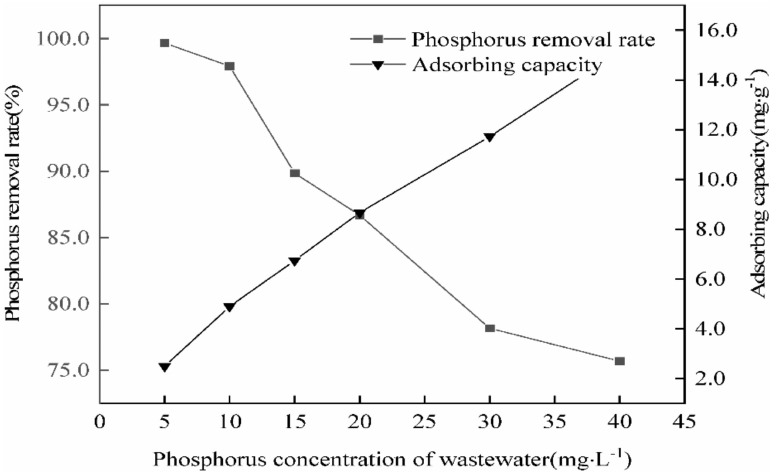
Figure 10. Effect of initial concentration of phosphorus-containing wastewater on phosphorus removal